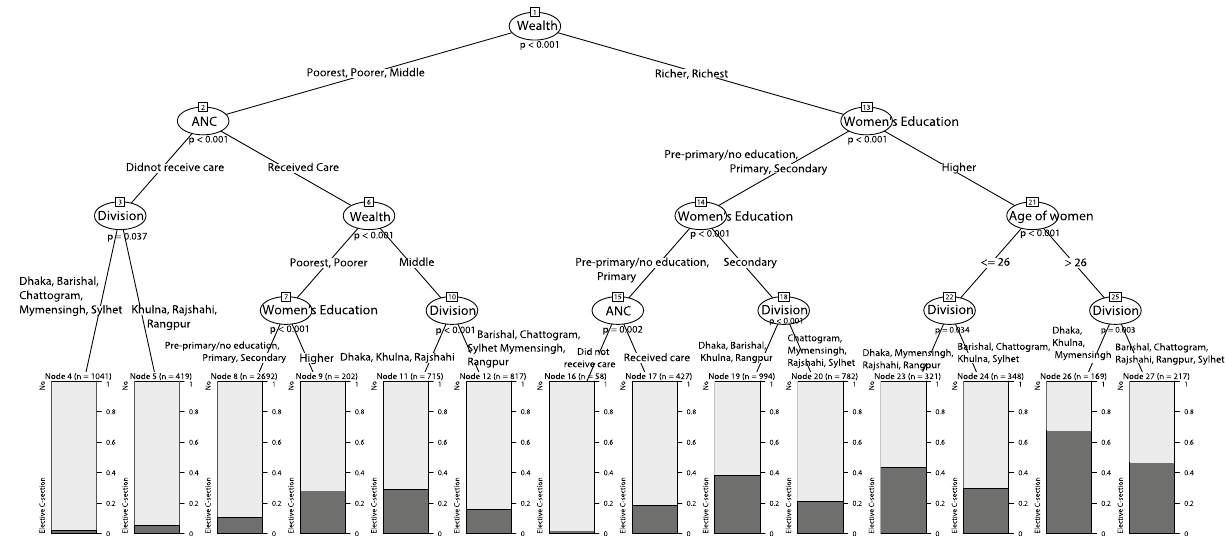
Figure 3. Classification tree diagram displaying the important predictors of elective CS for women in